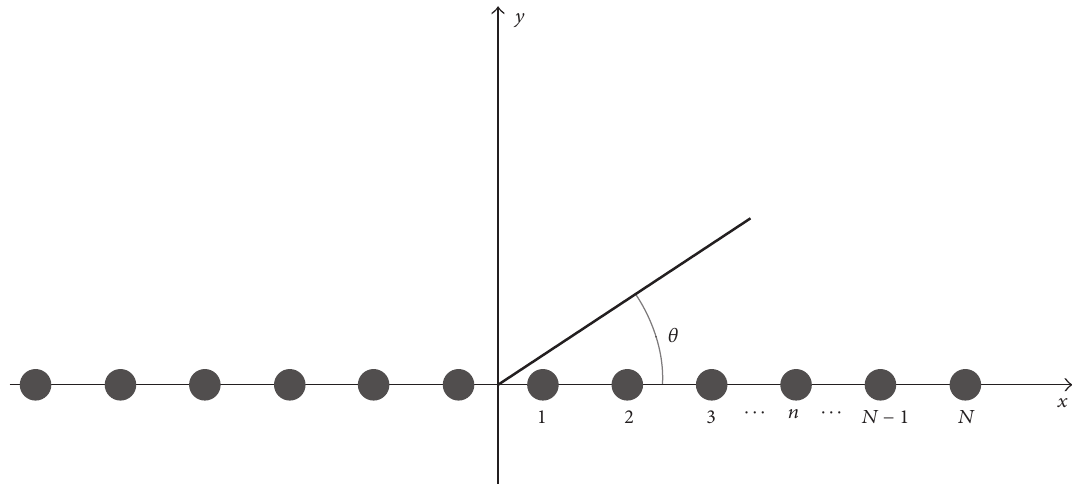
Figure 1: Geometry of 2𝑁 -element linear antenna